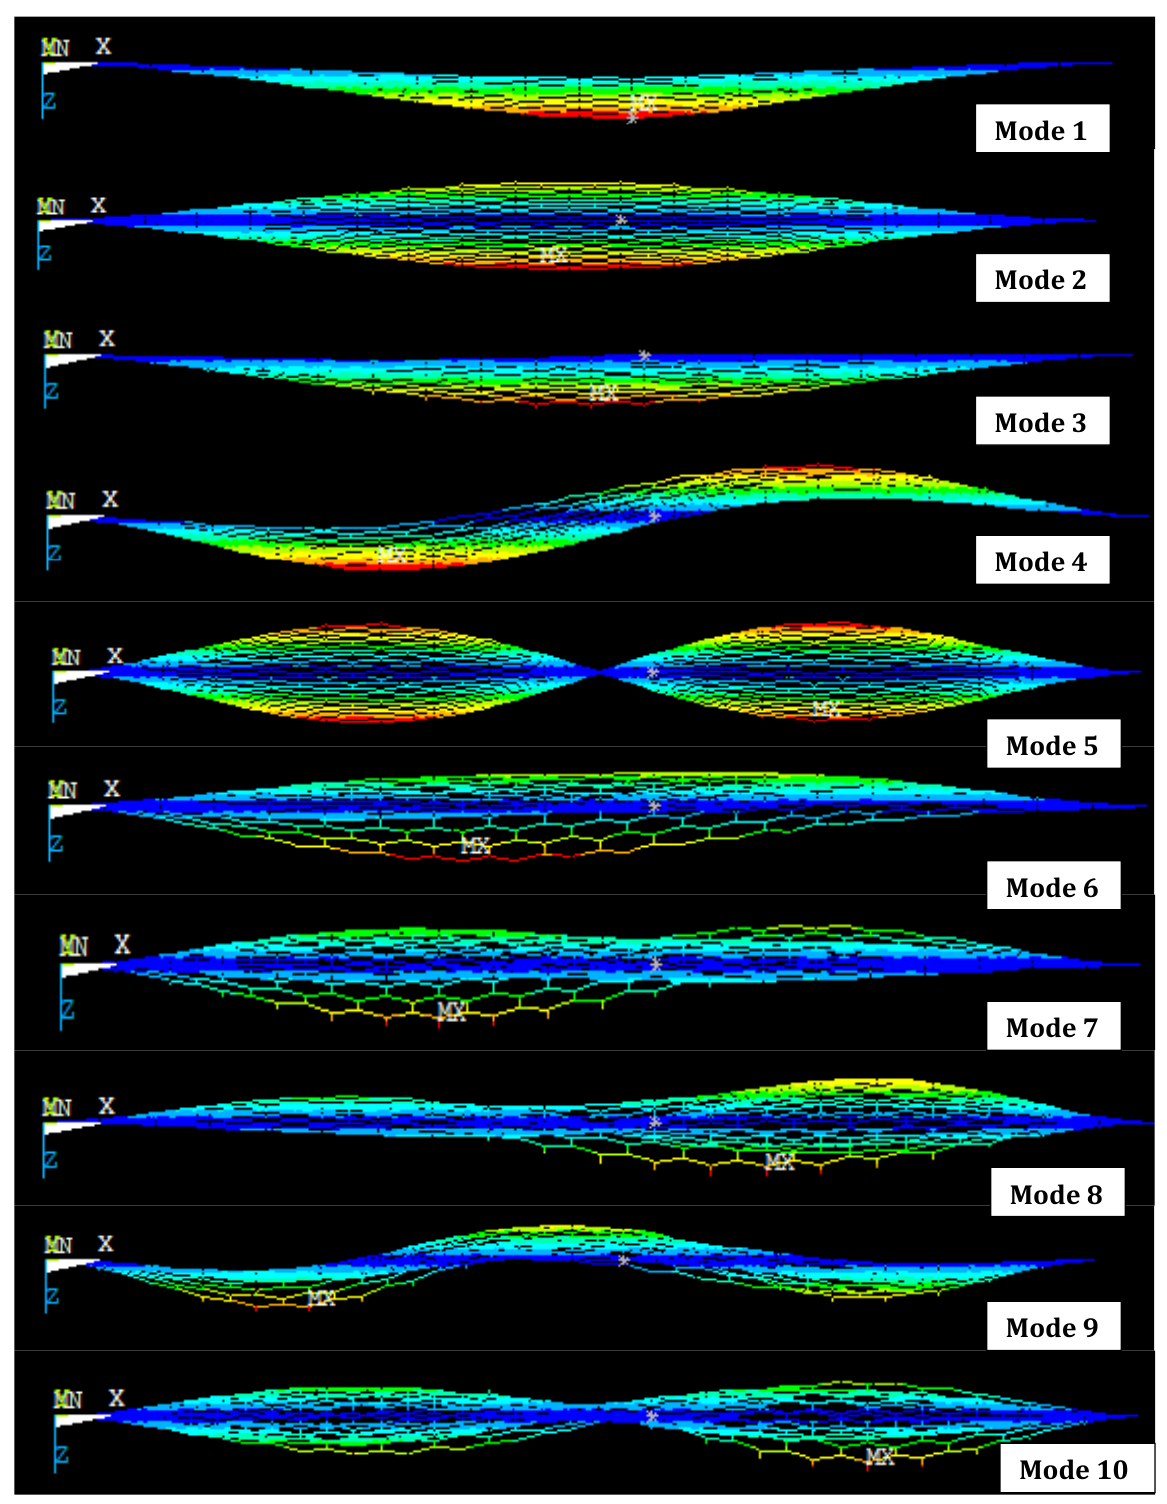
Figure 14. First ten mode shapes of bridged SLG (16, 4) with length 50 nm (front view of mode shape).